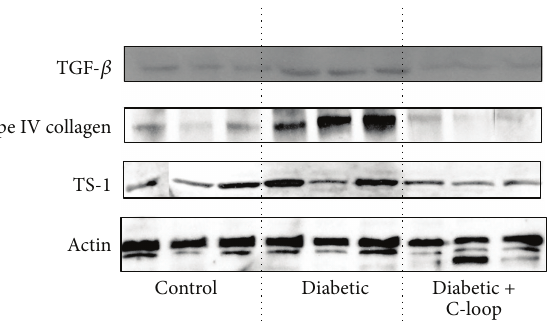
Figure 4: Biochemical analysis of kidney lysates. Kidney lysates from several rats in each group ( 𝑛 = 8 -9) were prepared and equal amounts of total protein were separated by SDS-PAGE prior to immunoblotting (IB) with either an anti-TGF- 𝛽 , anti-type IV collagen, or anti-TS-1 antibody. To demonstrate that any difference in protein levels was not due to a difference in the total amount of lysate, these extracts were also immunoblotted with an anti- actin antibody. The results from representative lysates of each group are shown. For each treatment group the protein band intensities from all the rats in the group were quantified using scanning densitometry.Thearbitraryscanningunits(mean ± SEM)areshown in Table